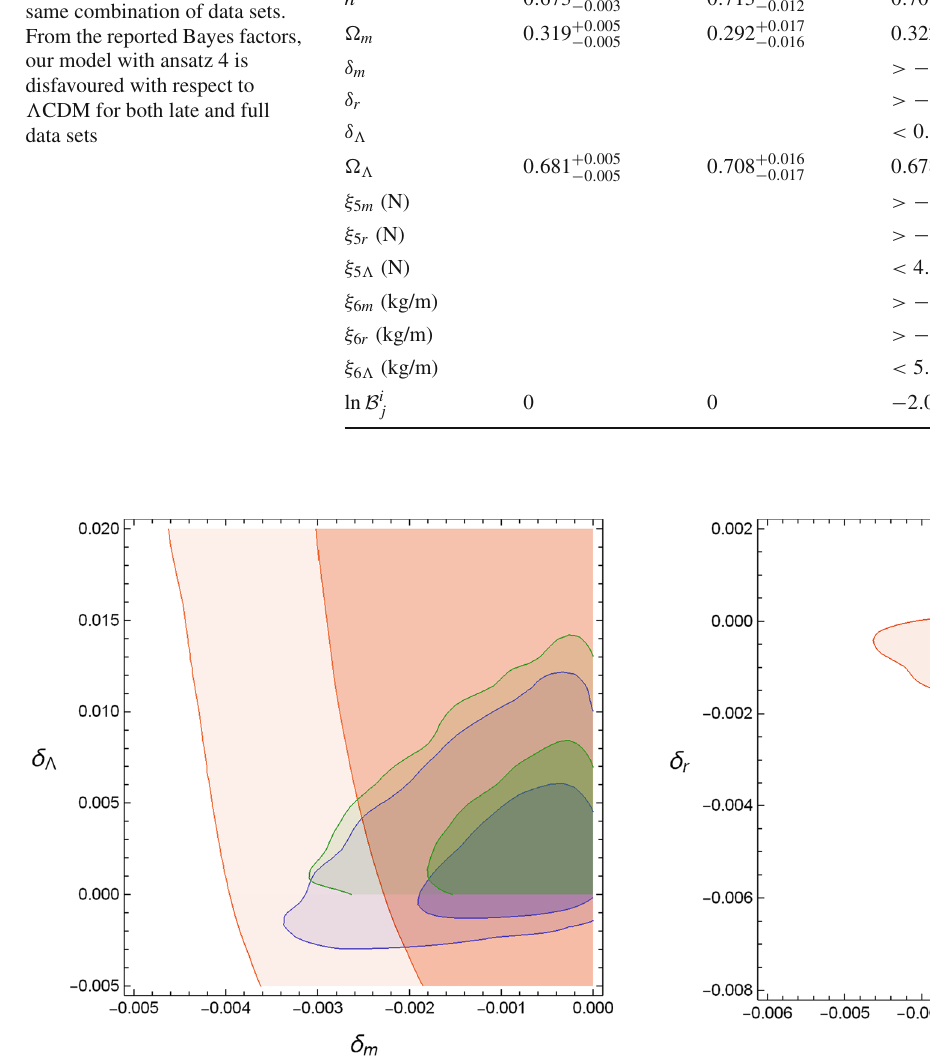
Fig. 2 1 σ and 2 σ contour plots in the parameter plane δ r − δ m for the two ansätze in which δ r (cid:16)= 0 (Ansatz 2 – grey; Ansatz 4 –